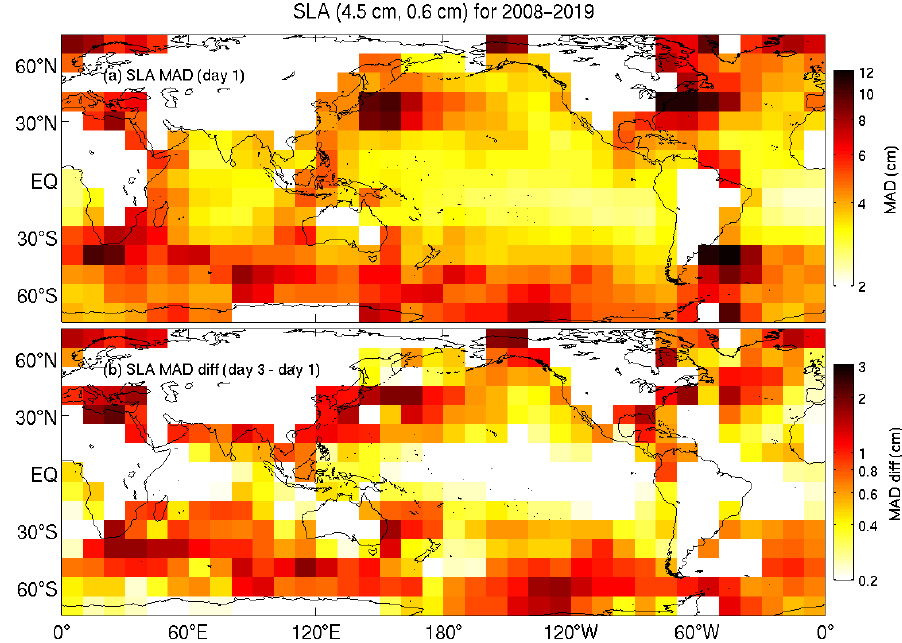
Figure 3. Binned sea-level mean absolute deviations, averaged over 2008–2019 from the first day (a) and day 3 minus day 1 (b) .